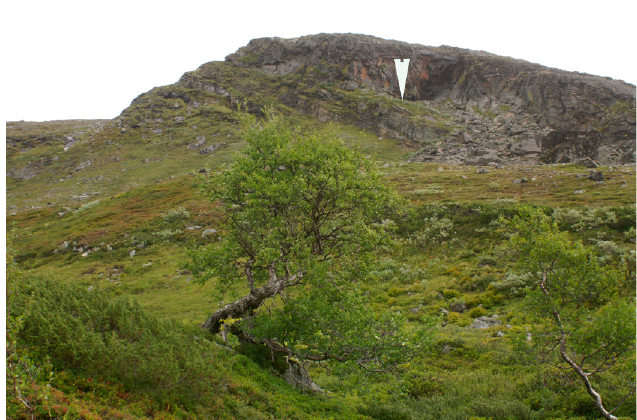
Figure 2: Old birch tree, representing the treeline position in 1915. The position of the raised treeline, 1010 m a.s.l., is indicated by the arrow. Mt. Mettjeburretjakke 885 m a.s.l. 6 September 2007.